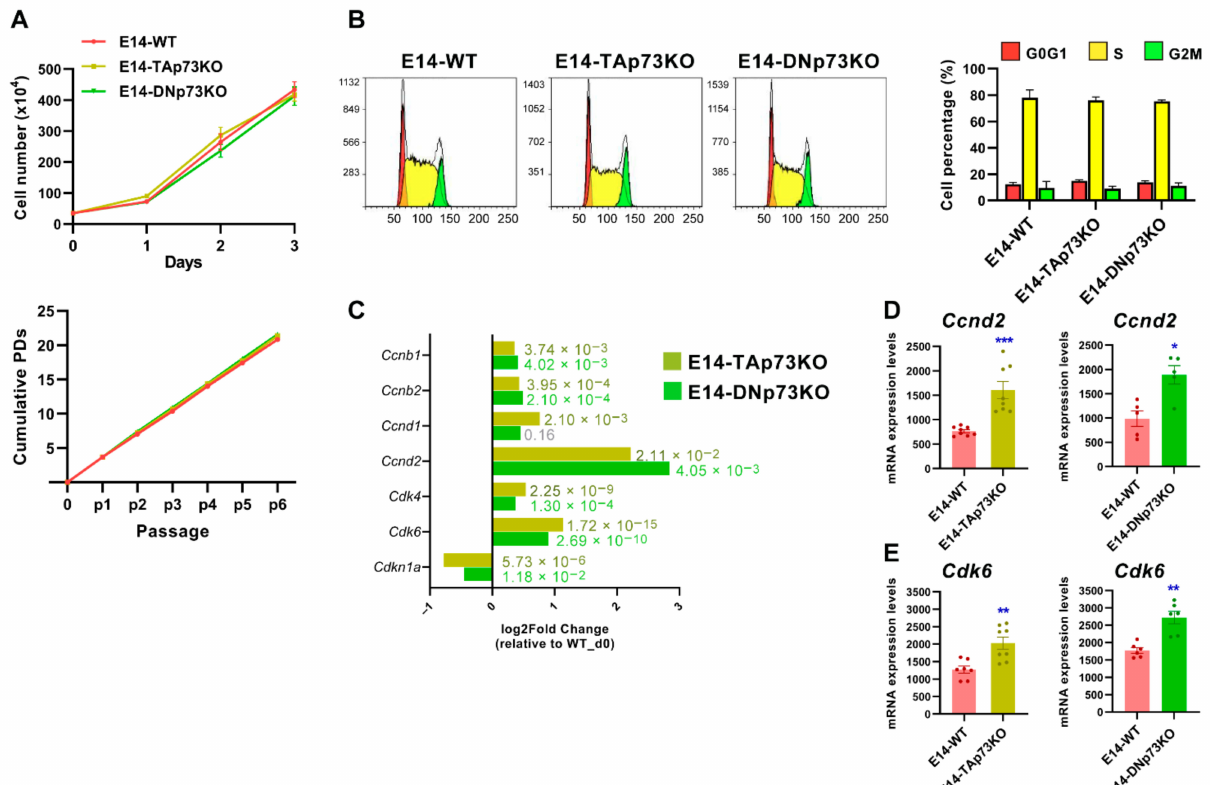
Figure 5. p73-isoforms are dispensable for mESC self-renewal but required for appropriate expression of G1 phase Cyclins/Cdk complexes. ( A ) Short-term and long-term growth curves of the indicated cell lines. Three independent experiments, with three replicates per condition, were performed. ( B ) Representative cell cycle profiles of the control and knockout cell lines. The quantification of the percentage of cells in each cell cycle phase using the Watson improved model showed no differences between genotypes. Bar graphs represent the mean ± SEM from three independent experiments. ( C ) Differential gene expression analysis of cell cycle-related genes (RNA-seq data) in E14-TA- and E14-DN-p73KO cells compared to E14-WT controls at day 0. ( D , E ) Analysis of Ccnd2 and Cdk6 upregulation by qRT-PCR analysis in E14- TAp73KO cells, respectively. * p -value < 0.05, ** p -value < 0.01, *** p -value <